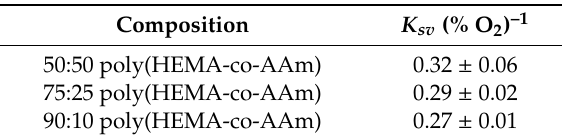
Table 2. Stern–Volmer constants of three urate biosensor compositions. Each value is an average of three samples ± 95% confidence intervals. Composition